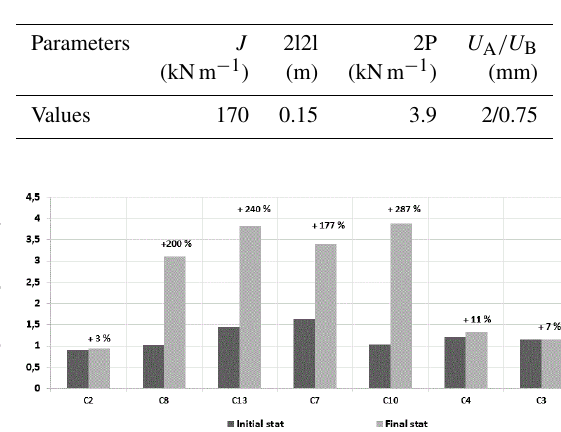
Table 2. Input parameters of Huckert model (2014).